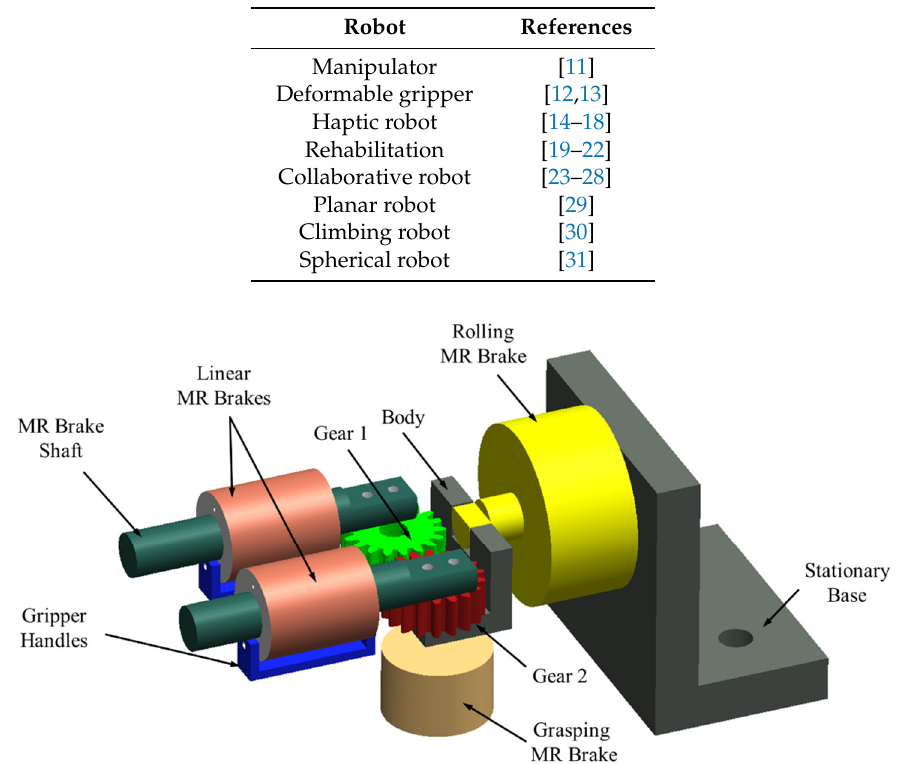
Table 2. Summary of state-of-the-art robotic applications using MRF.